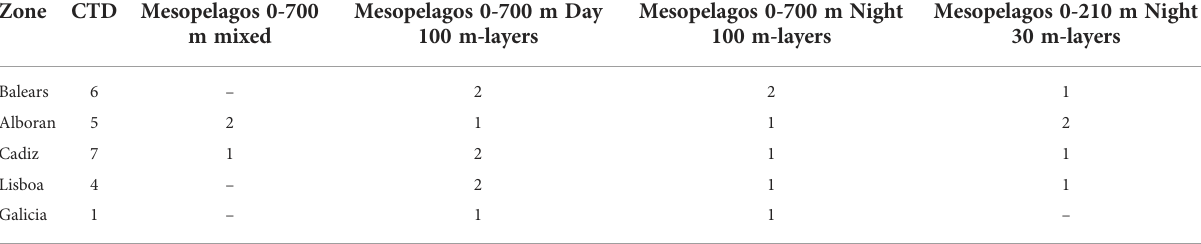
TABLE 1 Number of CTD casts and stations carried out per zone using the Mesopelagos net. Zone CTD Mesopelagos 0-700